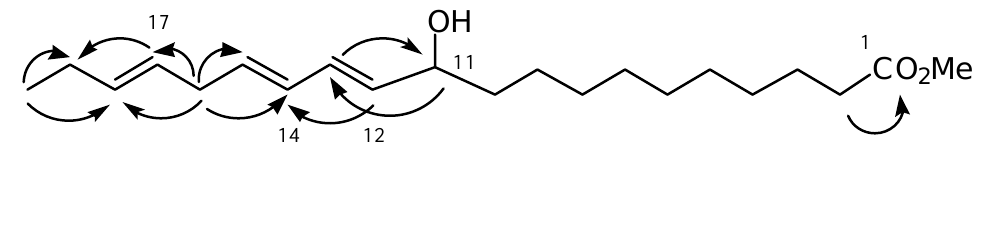
Figure 1. Selected HMBC correlations of compound 1 .